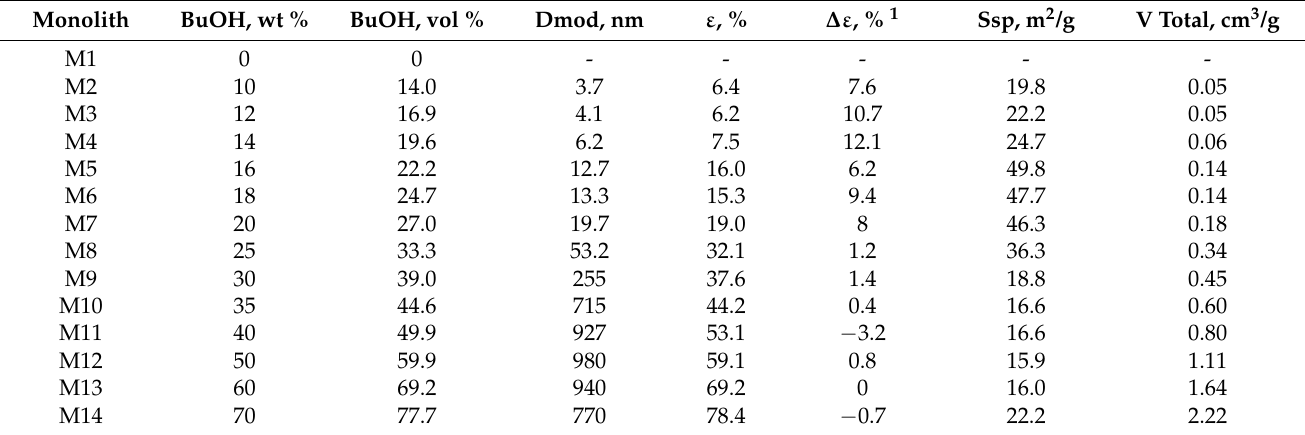
Table 1. Properties of porous poly-OCM-2 monoliths synthesized using various concentrations of porogenic